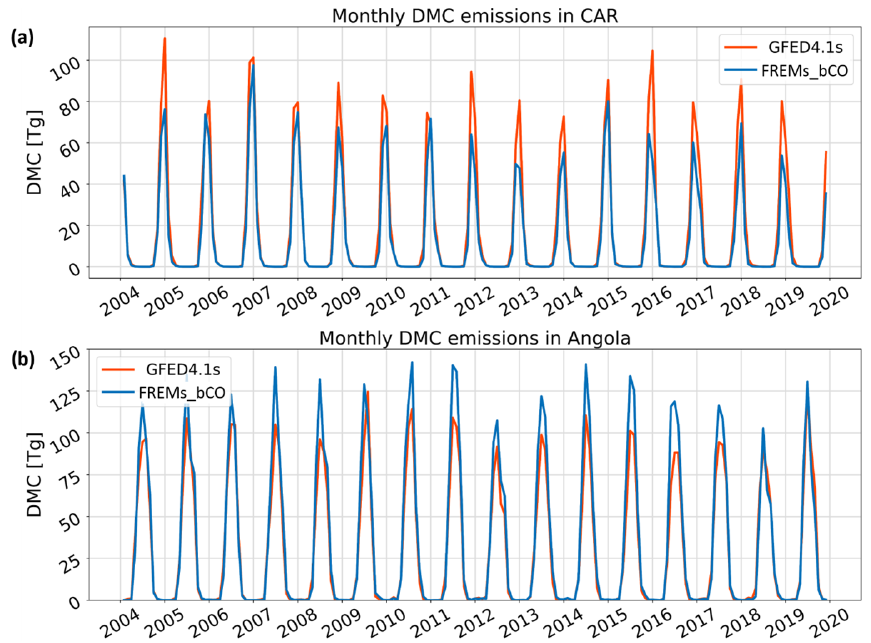
Figure 5. Monthly dry matter consumed (DMC in g) for a 16-year period as derived from FREMs_bCO CO emissions and that of GFED4.1s for (a) the Central African Republic (CAR) and (b)